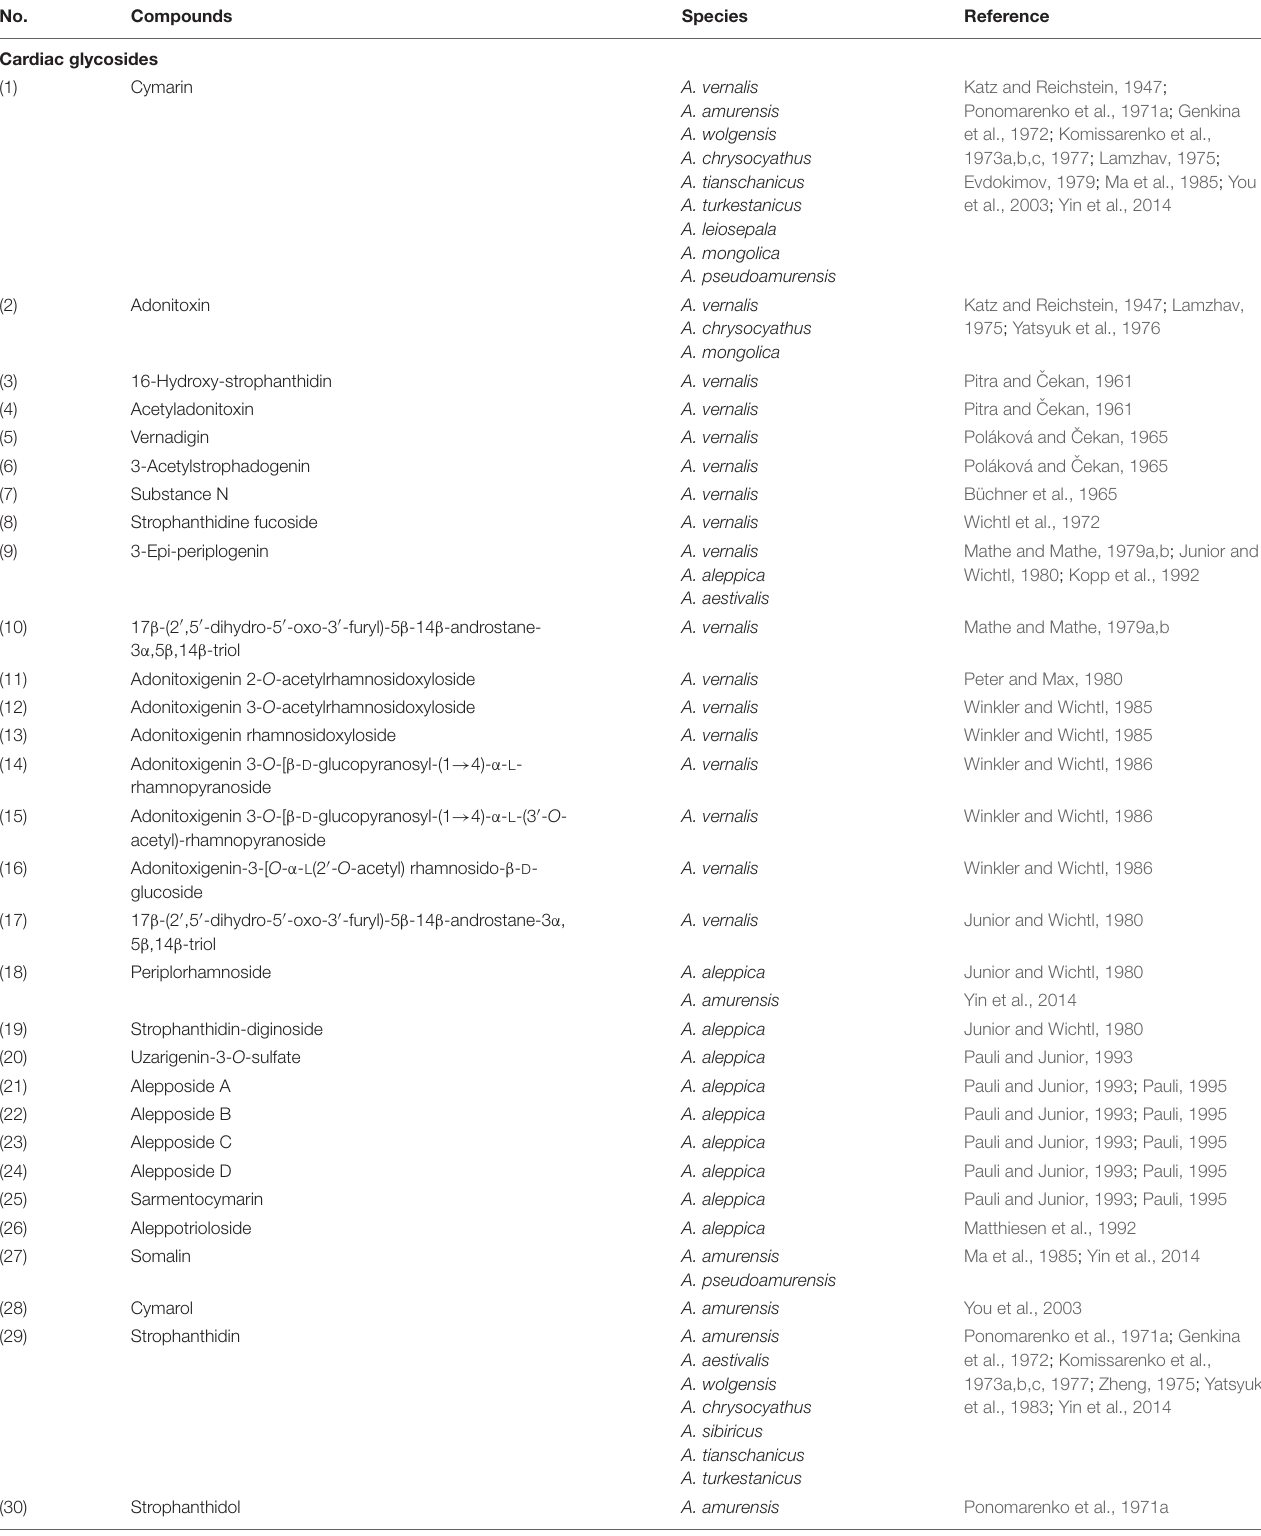
TABLE 2 | The isolated compounds from the genus Adonis. No. Compounds Species Reference Cardiac